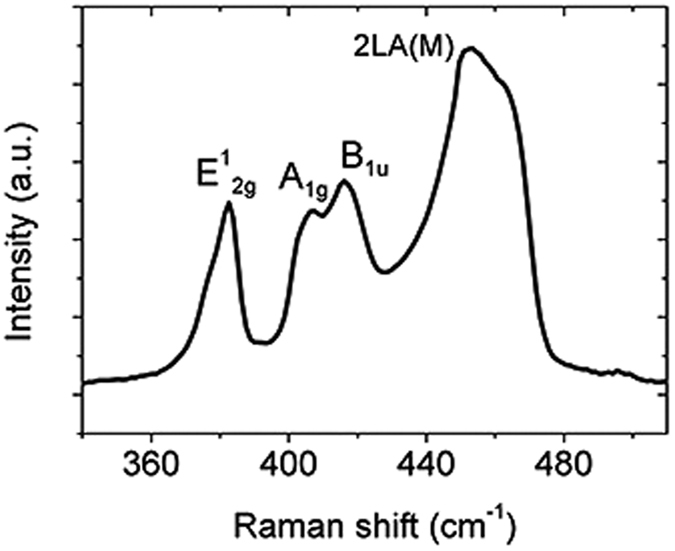
The Raman spectrum of multilayer MoS2 sample on a SiO2/Si substrate.